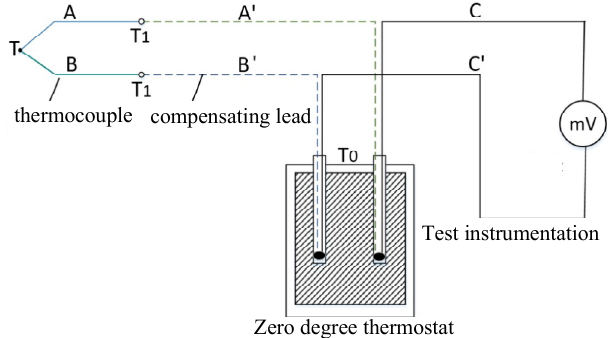
Figure 8. The basic composition of the thermocouple temperature measurement circuit.